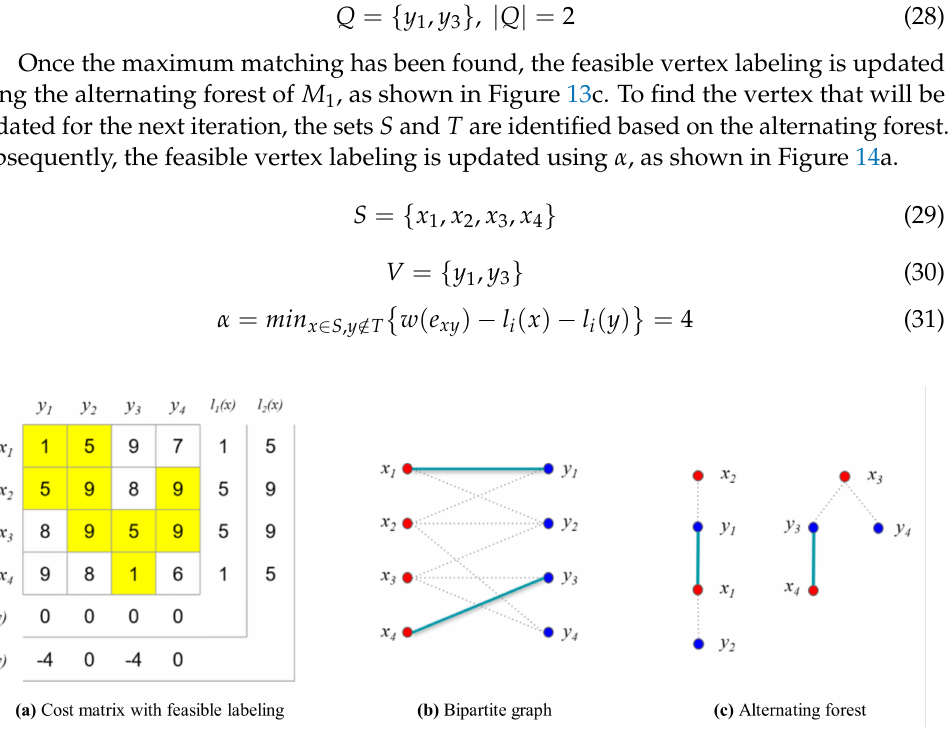
Figure 14. Example for the numerical experiment ( i = 2, j =